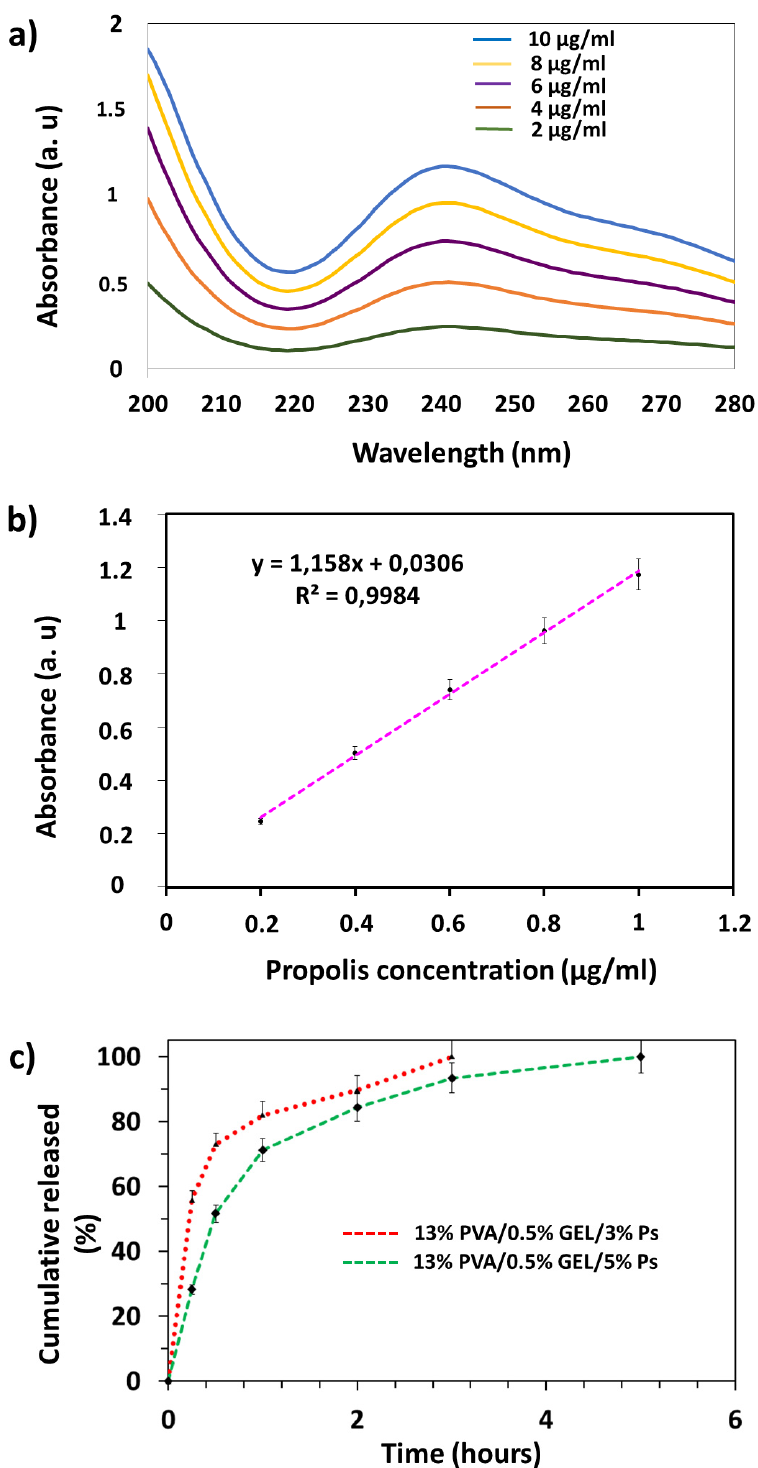
Figure 6. In vitro drug release profiles of scaffolds: Ps calibration curve ( a ), Absorption spectra of Ps at different amounts ( b ), Ps cumulative release graph ( c ).